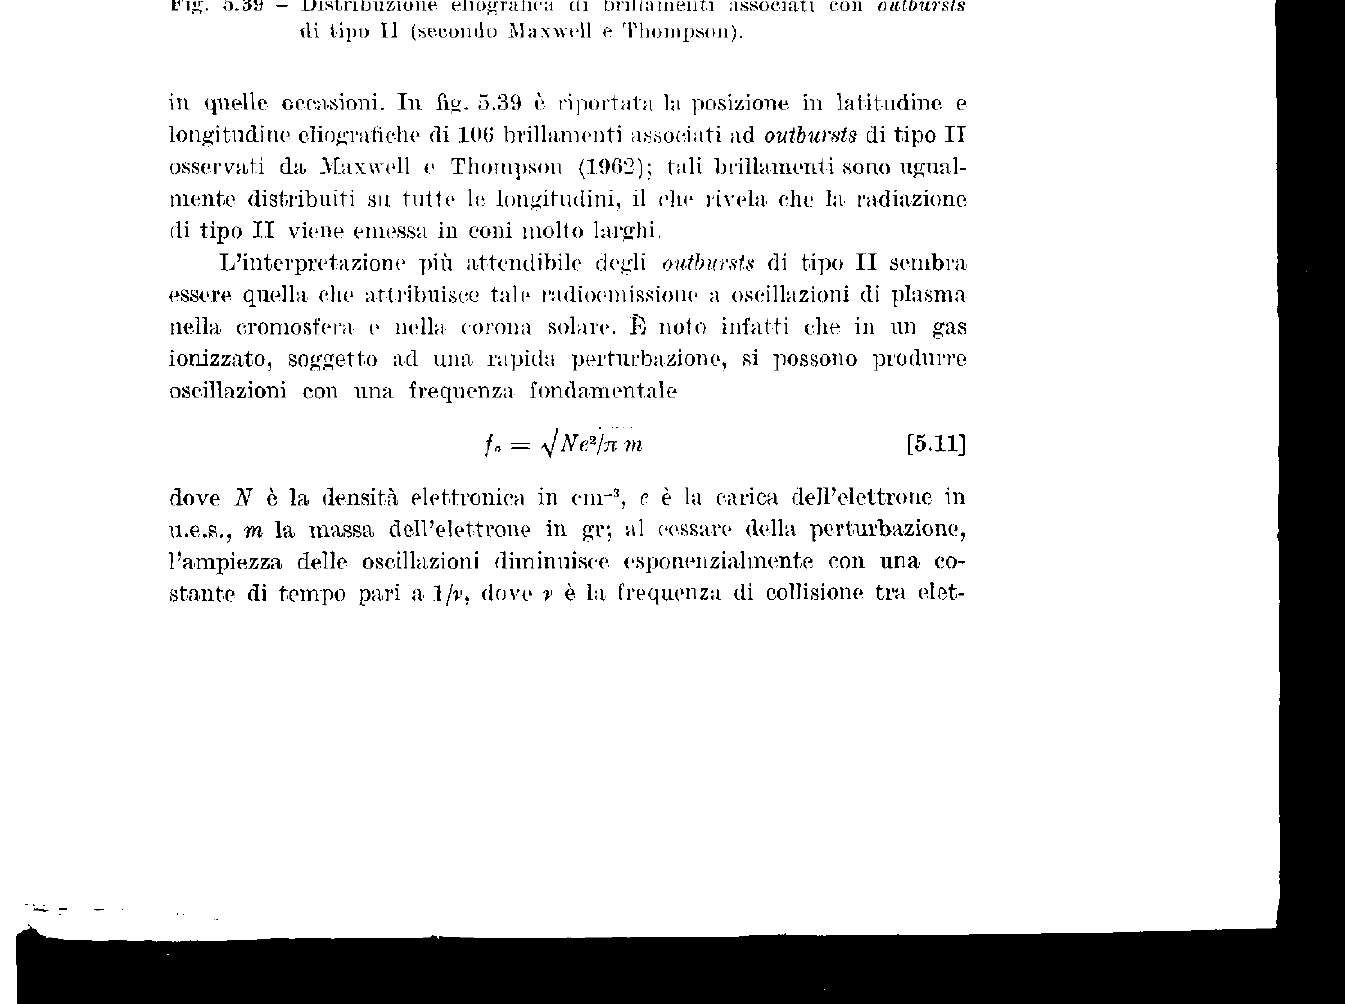
Fig. 5.39 - Distribuzione eliografica di brillamenti associati con outbursts di tipo li (secondo Maxwell e